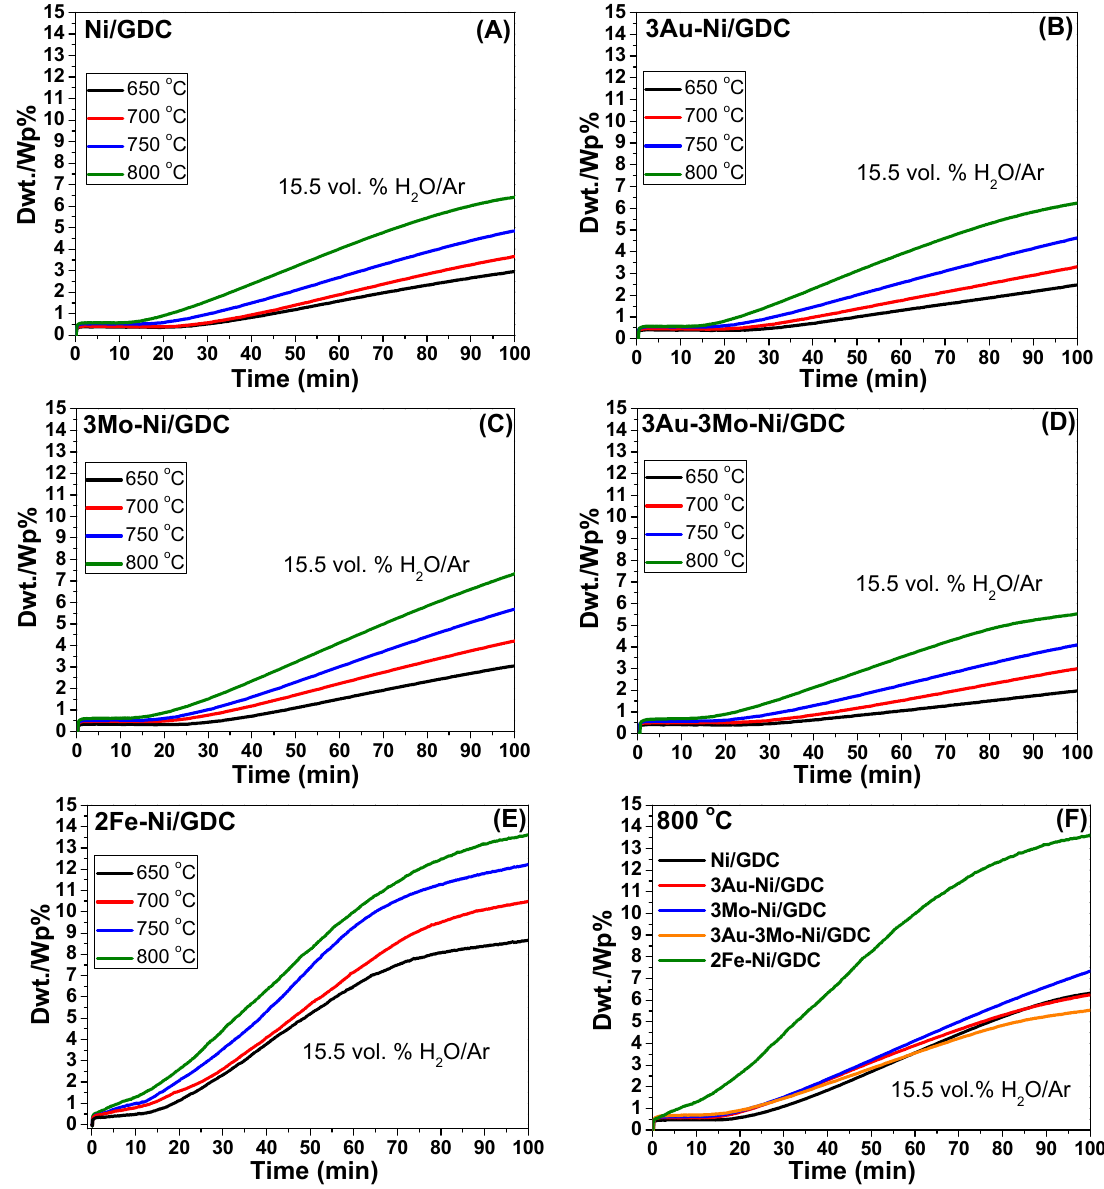
Figure 2. Isothermal TG analysis of the pre-reduced, ( A ) Ni/GDC, ( B ) 3wt% Au-Ni/GDC, ( C ) 3wt% Mo-Ni/GDC, ( D ) 3wt% Au–3wt% Mo-Ni/GDC, and ( E ) 2wt% Fe-Ni/GDC samples in the temperature range between 650–800 ◦ C. ( F ) Comparative TG profiles of the samples at 800 ◦ C. Feed Conditions: 15.5 vol.% H 2 O/Ar, F total = 100 cm 3 /min (STP conditions: 0 ◦ C, 1 atm).